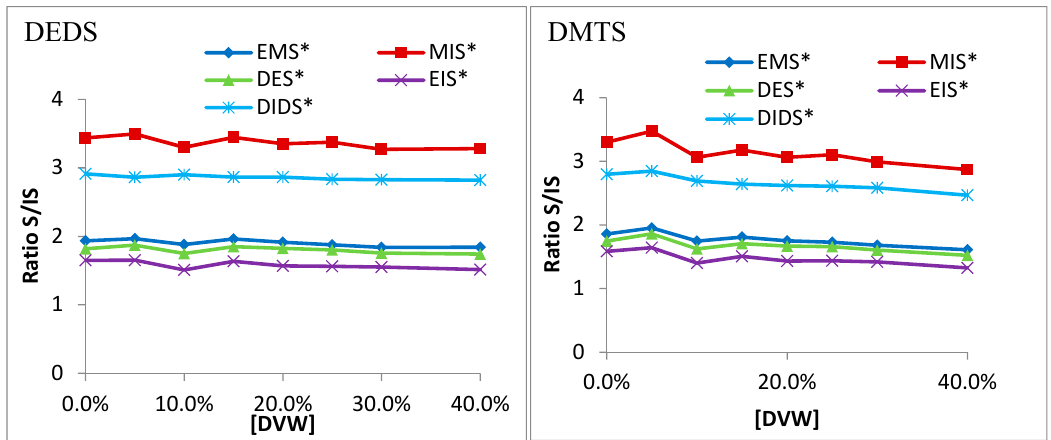
Figure 3. Analyte-to-internal-standard ratios to all five internal standards in merlot DVW of DMS, MeSOAc, DMDS, EtSOAc, DEDS, and DMTS.